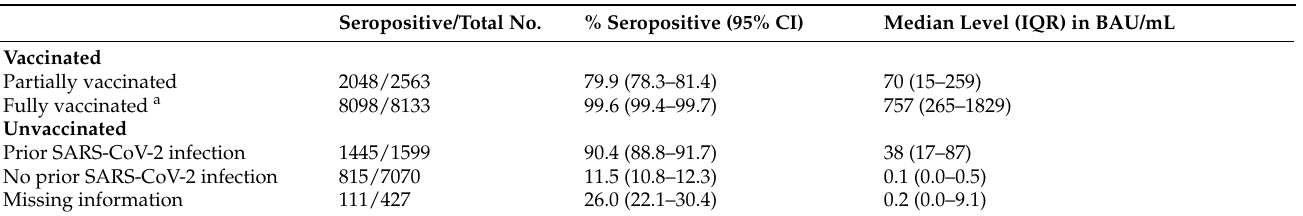
Table 2. Seroprevalence of anti-S IgG antibodies in vaccinated and unvaccinated study participants;